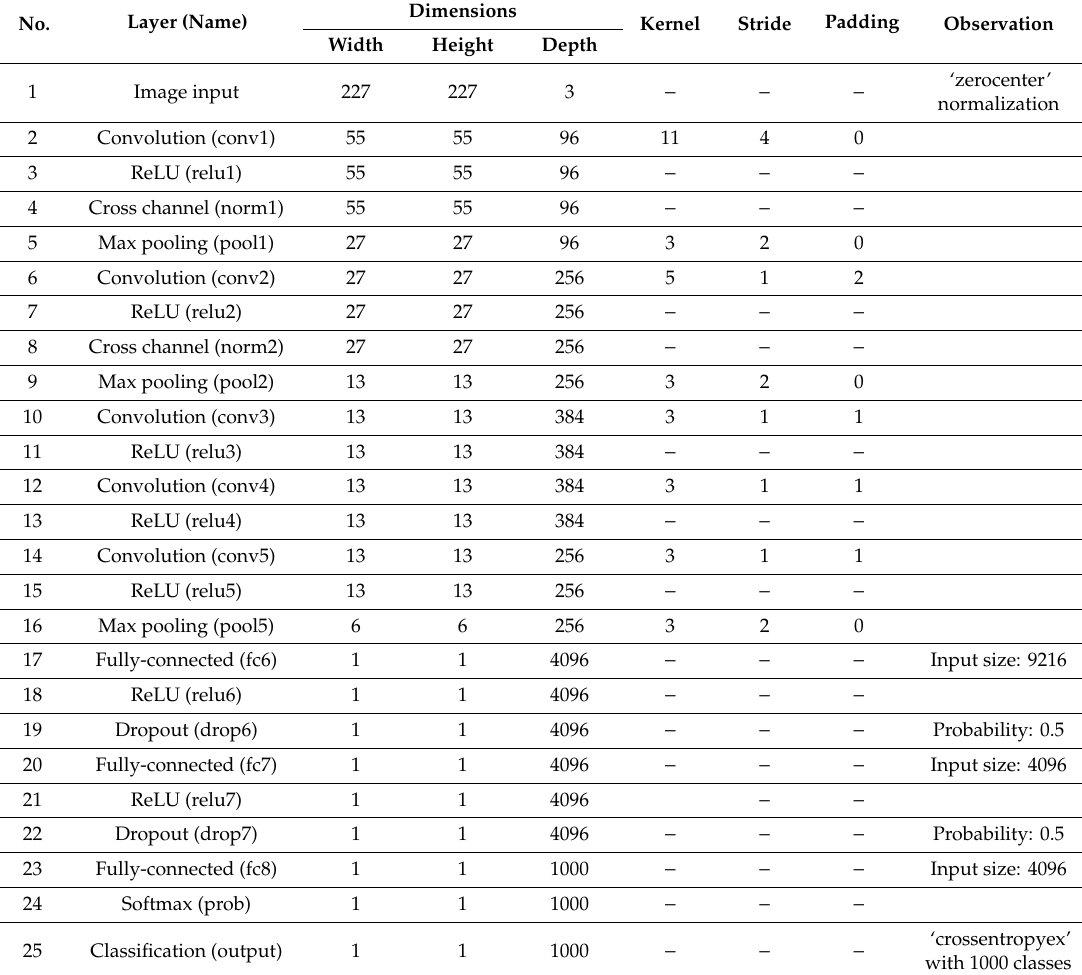
Table 4. AlexNet deep network in DL Matlab ™ toolbox (adapted from Hertel et al.,